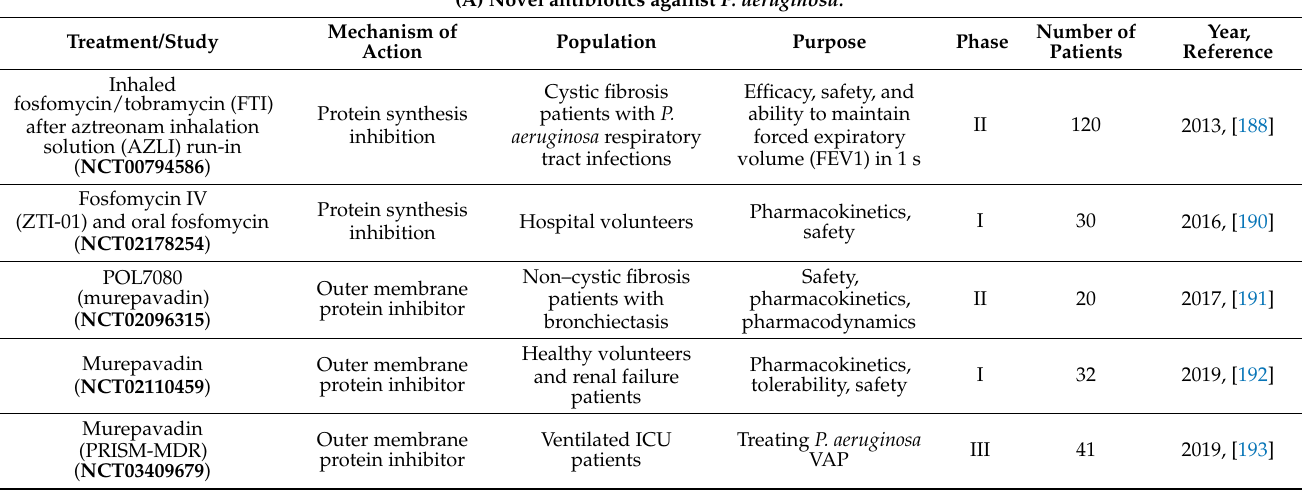
Table 1. ( A ). Novel antibiotics against P. aeruginosa. ( B ). Beta-lactamase inhibitors targeting P. aeruginosa